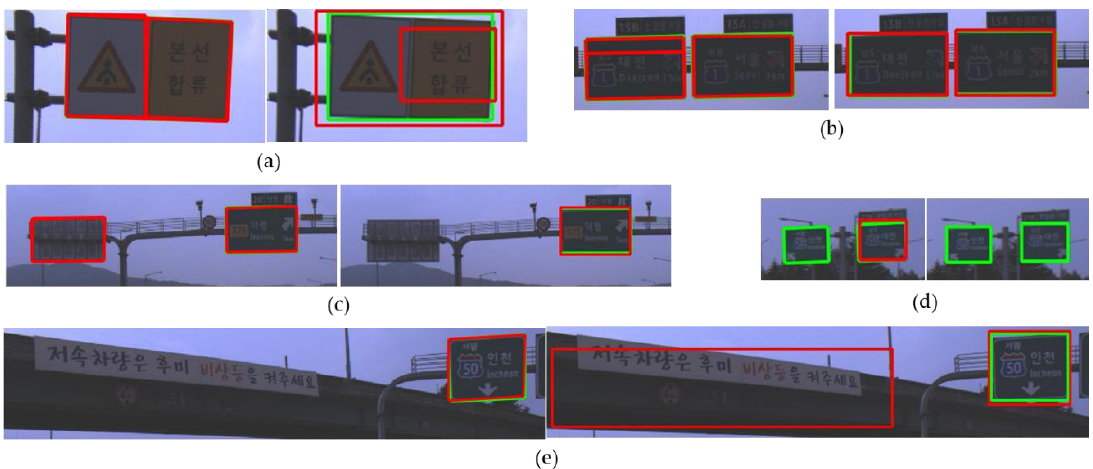
Figure 14. Comparison of the detection errors between the proposed method and YOLOv3 (left: the proposed method, right: YOLOv3). ( a ) a road sign consisting of two colors, ( b ) a road sign not precisely detected by the proposed method, ( c ) a road sign falsely detected by the proposed method, ( d ) road signs not detected, ( e ) a road sign falsely detected by YOLOv3.